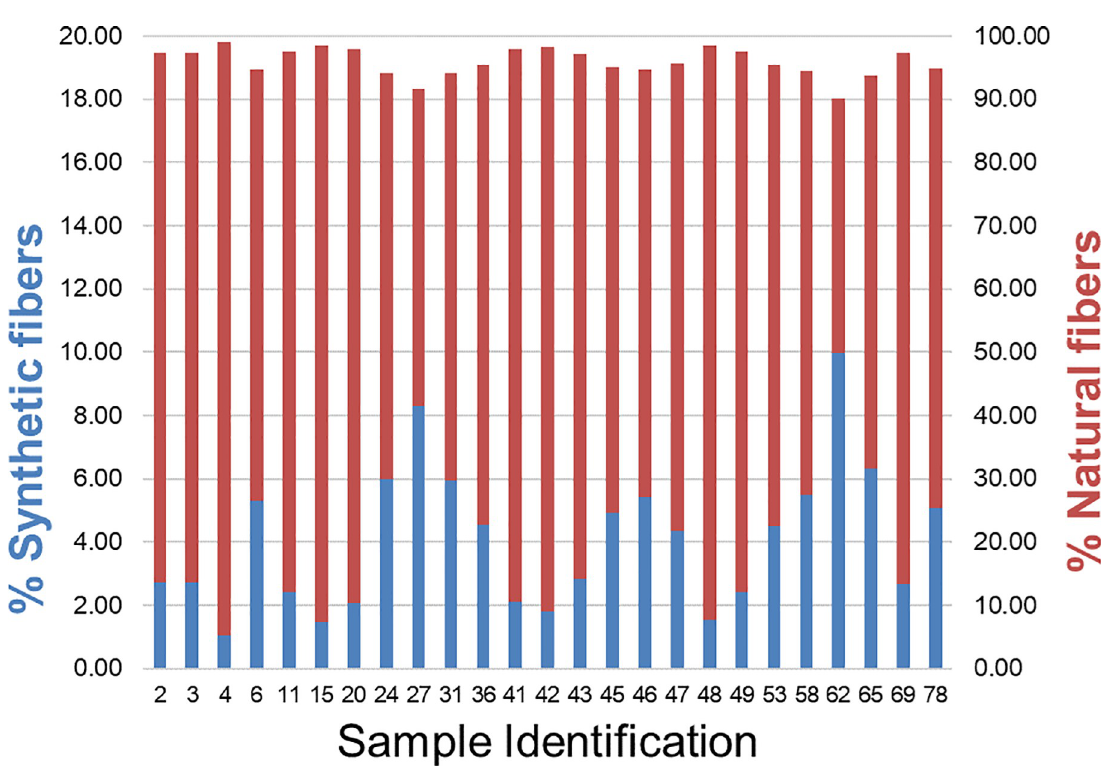
Fig 3. Percentage composition after fiber digestion.